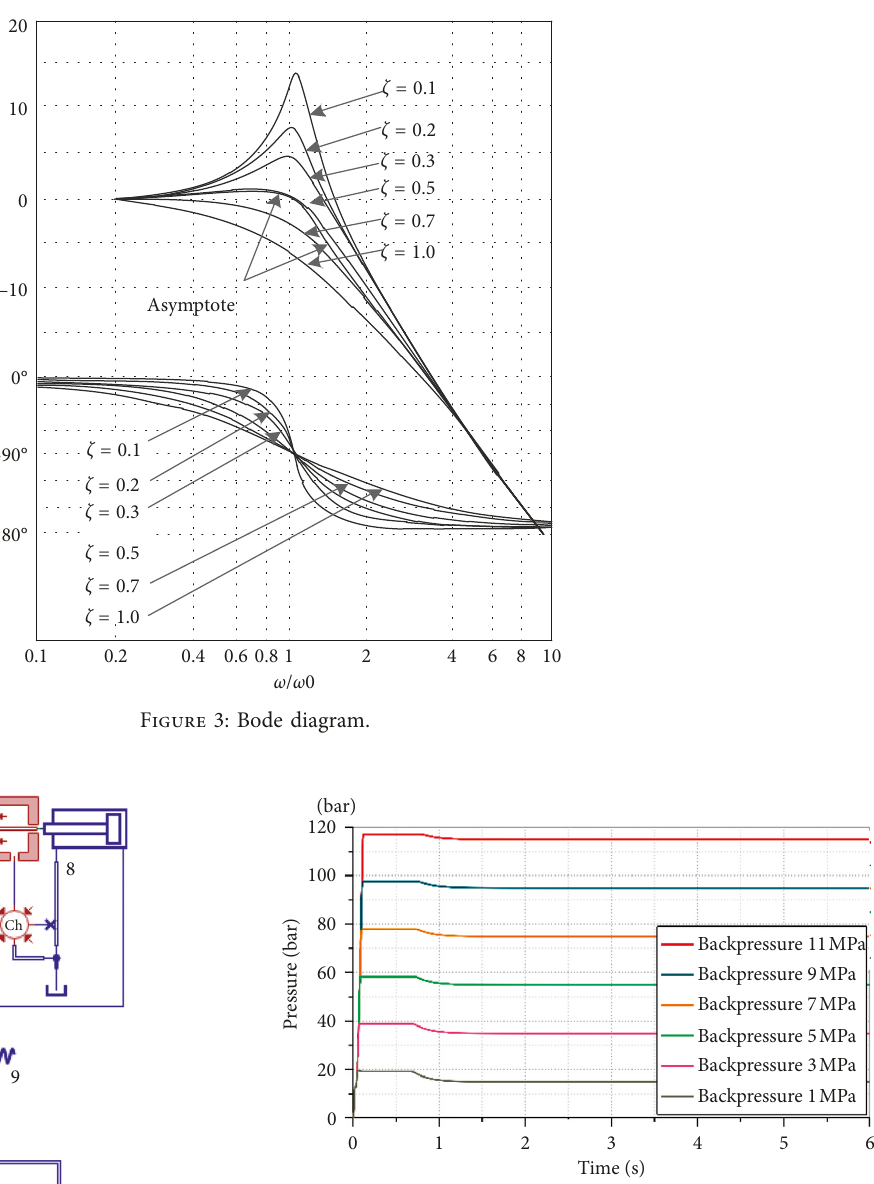
Figure 5: Pressure changes of the cylinder without rod